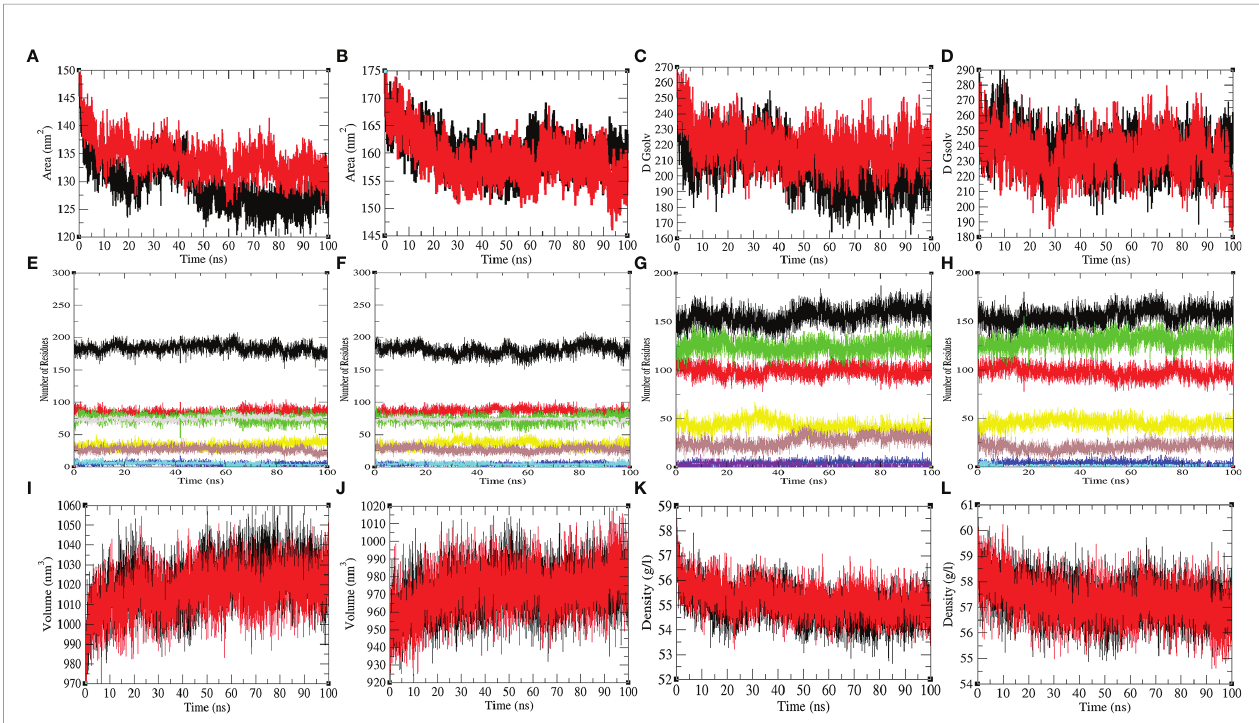
FIGURE 4 | The SASA and secondary structure plot. The SASA plot of (A) Mprotease (black) and Mprotease-psilacetin (red), (B) HIK6 (black) and HIK6-psilacetin (red). The free energy of solvation for (C) Mprotease (black) and Mprotease-psilacetin (red), (D) HIK6 (black) and HIK6-psilacetin (red). The graphical representation indicates structural elements present in (E) Mprotease, (F) Mprotease-psilacetin, (G) HIK6, and (H) HIK6-psilacetin. The structural volume (I) Mprotease (black) and Mprotease-psilacetin (red), (J) HIK6 (black) and HIK6-psilacetin (red), and the density of (K) Mprotease (black) and Mprotease-psilacetin (red), (L) HIK6 (black) and HIK6-psilacetin (red) calculated during MD